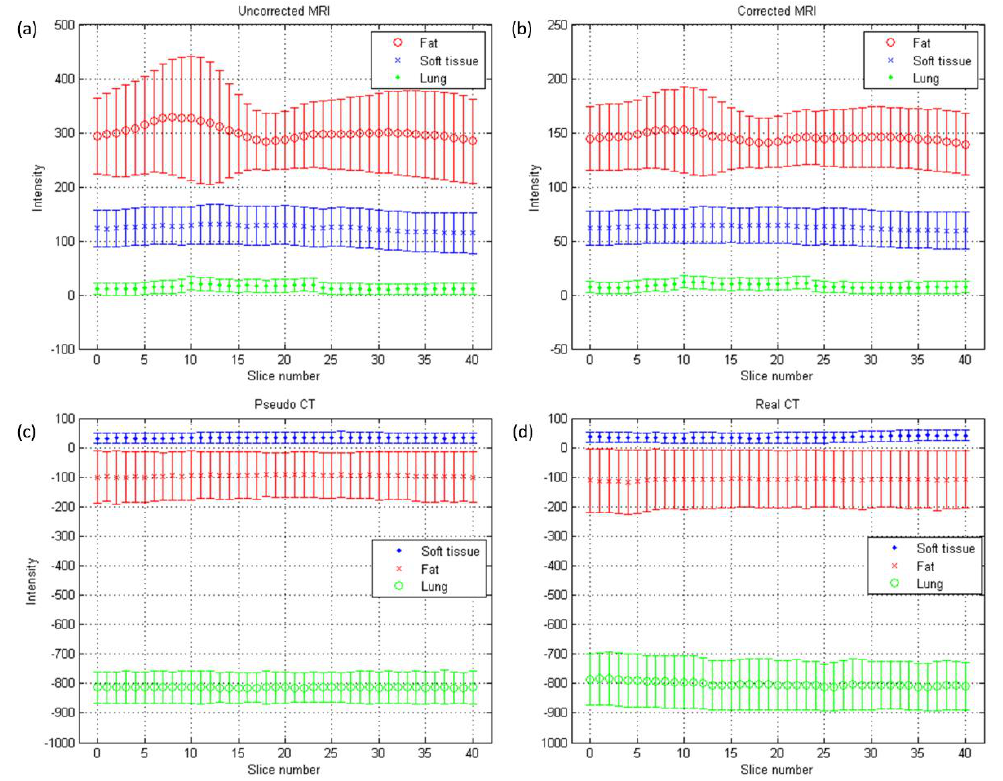
Figure 9. Mean (central line) and standard deviation (error bar) of chest imaging for cancer treatment: ( a ) uncorrected MRI, ( b ) corrected MRI, ( c ) pseudo-CT, and ( d ) real CT.